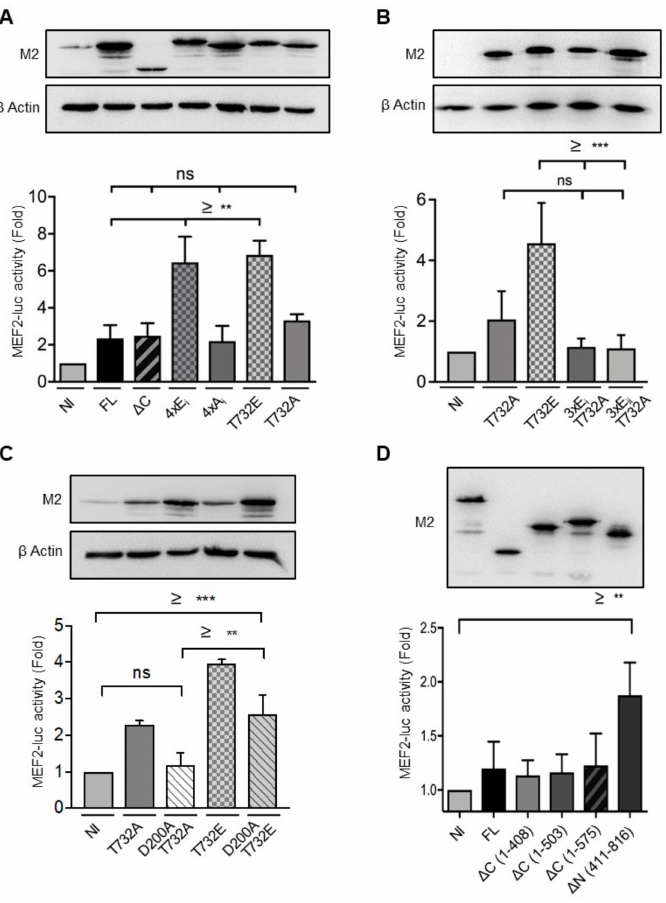
Figure 4. Phosphorylation at Thr 732 enhances ERK5-mediated transcription. Recombinant Flp-In HeLa cell lines were transfected with a construct encoding a MEF2 luciferase reporter. ( A–D ) 24 h later, the cells were incubated with tetracycline for 48 hours to induce expression of ERKFL, ERK5- ∆ C and ERK5- ∆ N fragments, or specific phospho-deficient or phosphomimetics mutants, as indicated. Non-induced (NI) cells were used as controls. E ffi ciency of transfection was controlled by co-transfecting a Renilla firefly encoding construct. Immunoblot analyses of the cell lysates demonstrate similar level of expression of ERK5-FL and the various mutants. The MEF2 luciferase activity normalized to that of Renilla luciferase is expressed as fold to compare relative transcriptional activity under basal condition. The data represent the mean ± SD of three independent experiments performed in duplicate. ** p < 0.01 and *** p < 0.001 indicate significant di ff erences. ns indicates no statistical di ff